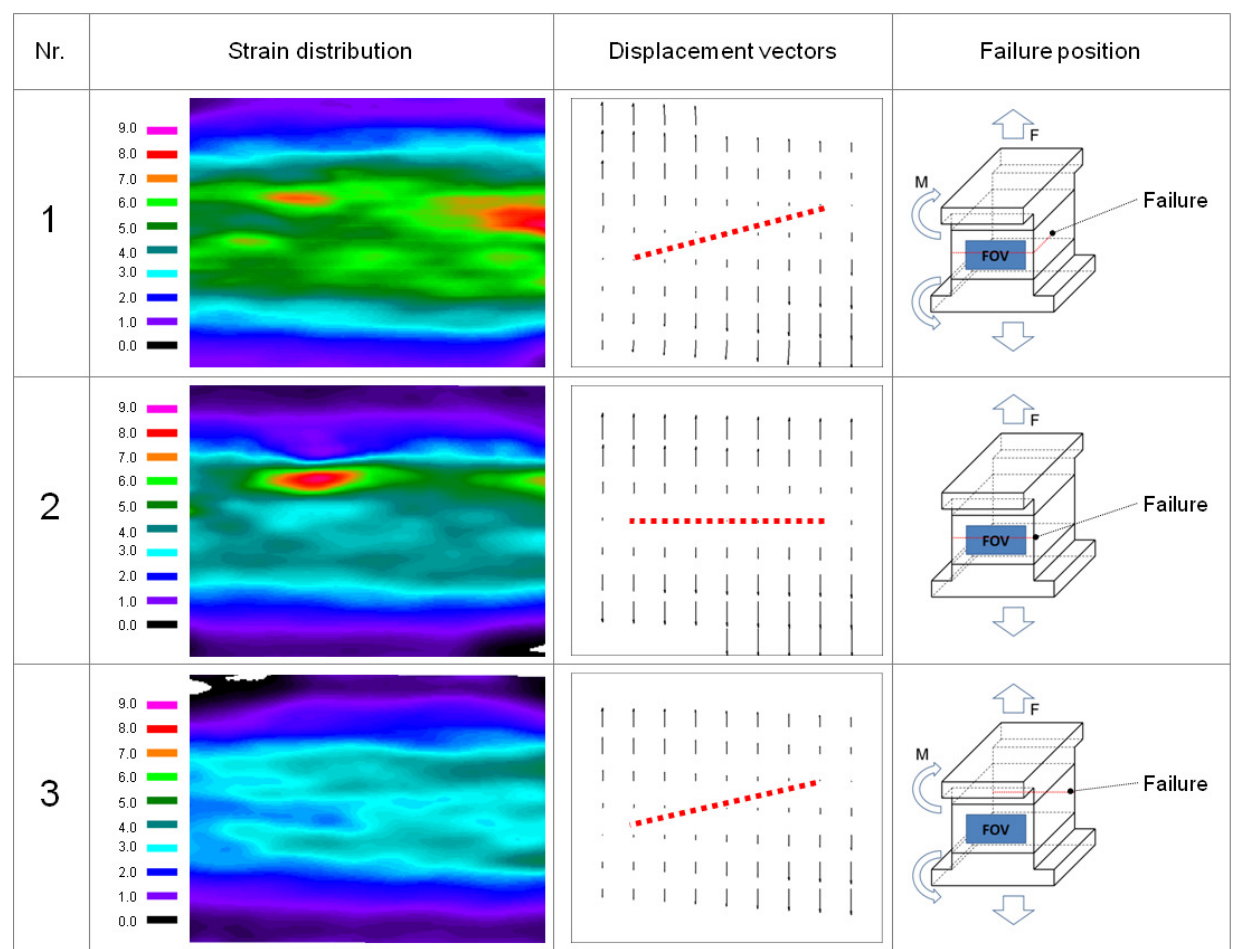
Figure 4. ( left ) In-plane strain distribution of Specimens 1, 2, 3; ( right ) Specimens 1, 2, 3 with field of view (FOV), failure zone and momentum